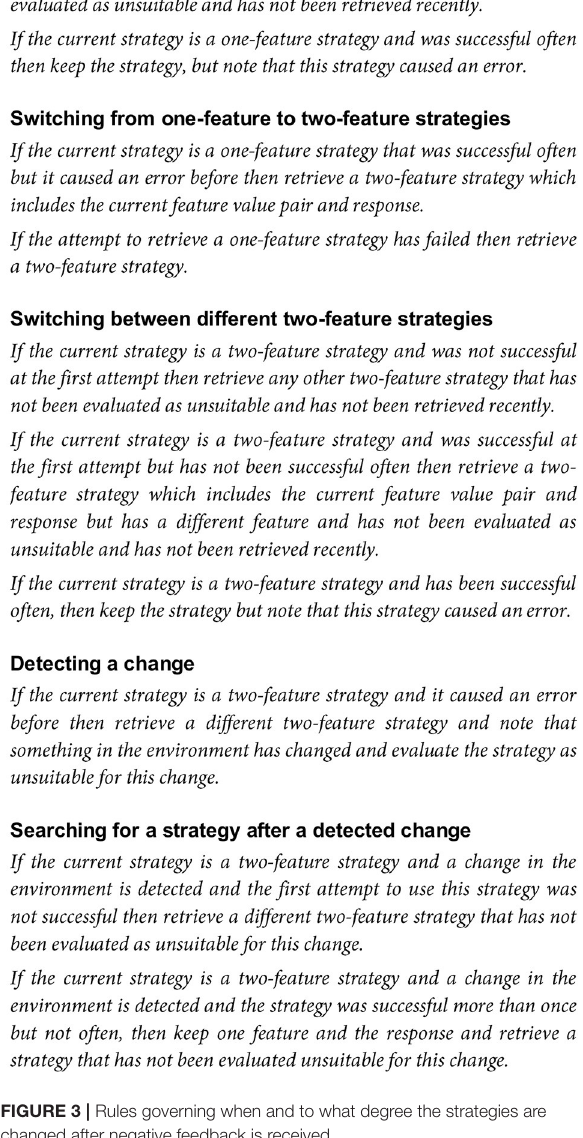
within the two-feature strategy are modeled the following way: If a two-feature strategy was unsuccessful at the first attempt, any other two-feature strategy is used (which one exactly is